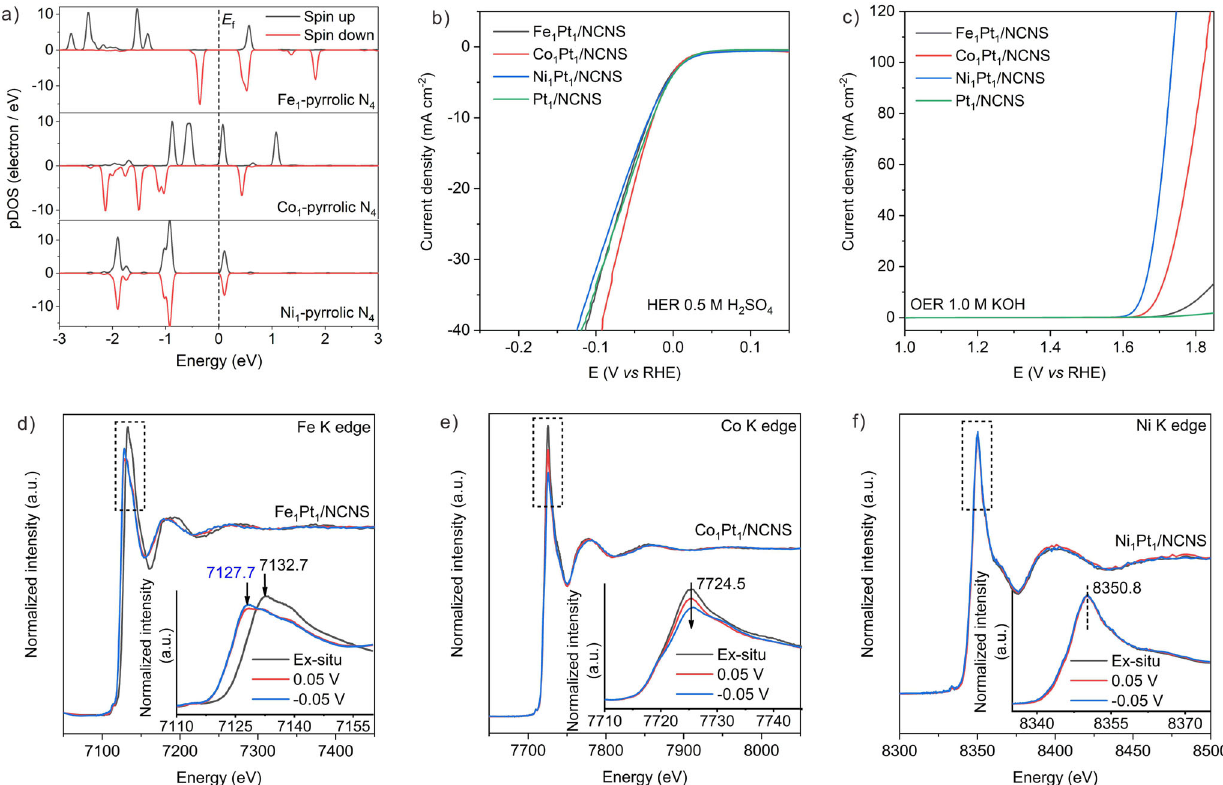
Fig. 6 Theoretical and experimental electrocatalytic analysis on M 1 Pt 1 /NCNS (M = Co, Fe, and Ni). a Projected density of state (pDOS) on the M 1 3 d orbitals with the Fermi level set at zero. HER ( b ) and OER ( c ) LSV curves of M 1 Pt 1 /NCNS and Pt 1 /NCNS with IR correction. d – f Operando XANES study on M 1 Pt 1 /NCNS catalysts in HER working conditions under different potentials at Fe, Co, and Ni K edges, respectively. Inserts: the enlarged area of XANES region in the dash